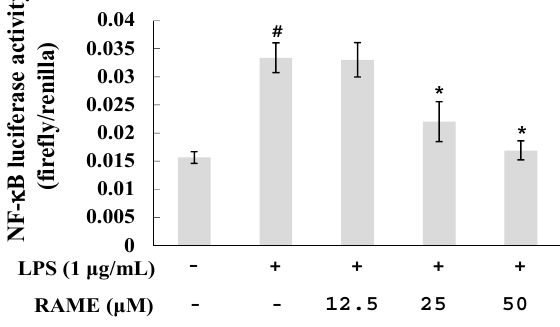
Figure 3. Effects of RAME on the NF- κ B pathway. # p < 0.05 vs. control group , * p < 0.05 vs. LPS-treated group.